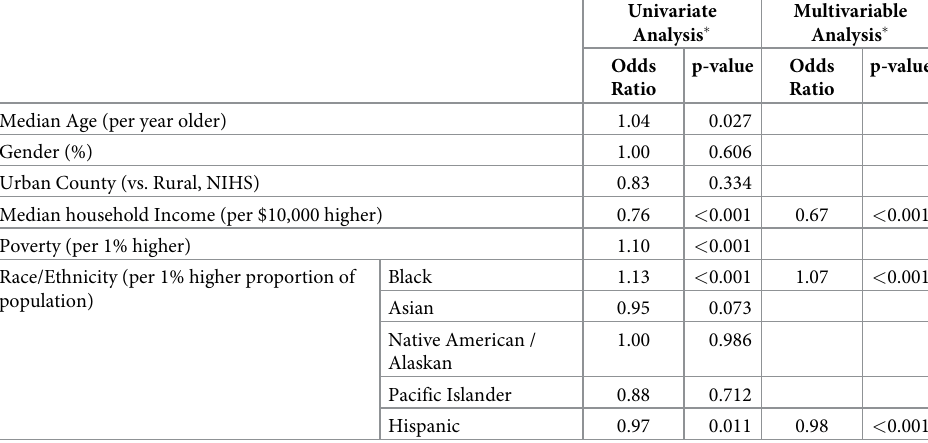
Table 2. Socioeconomic and demographic predictors of the prevalence of blindness.